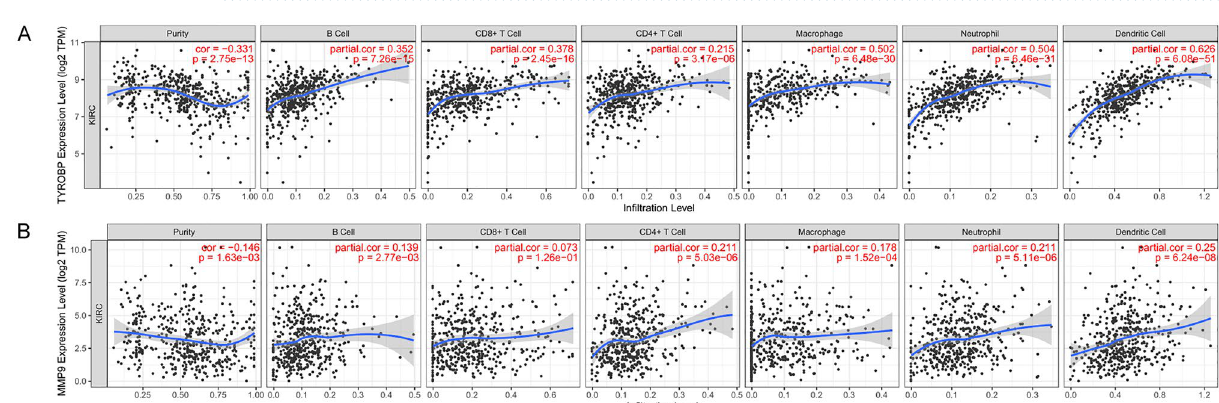
Figure 7. Correlation analysis of key genes expression with tumor immune-associated cells. ( A , B ) Relationship between MMP9 and TYROBP expression and the level of tumor-associated immune cell infiltration in